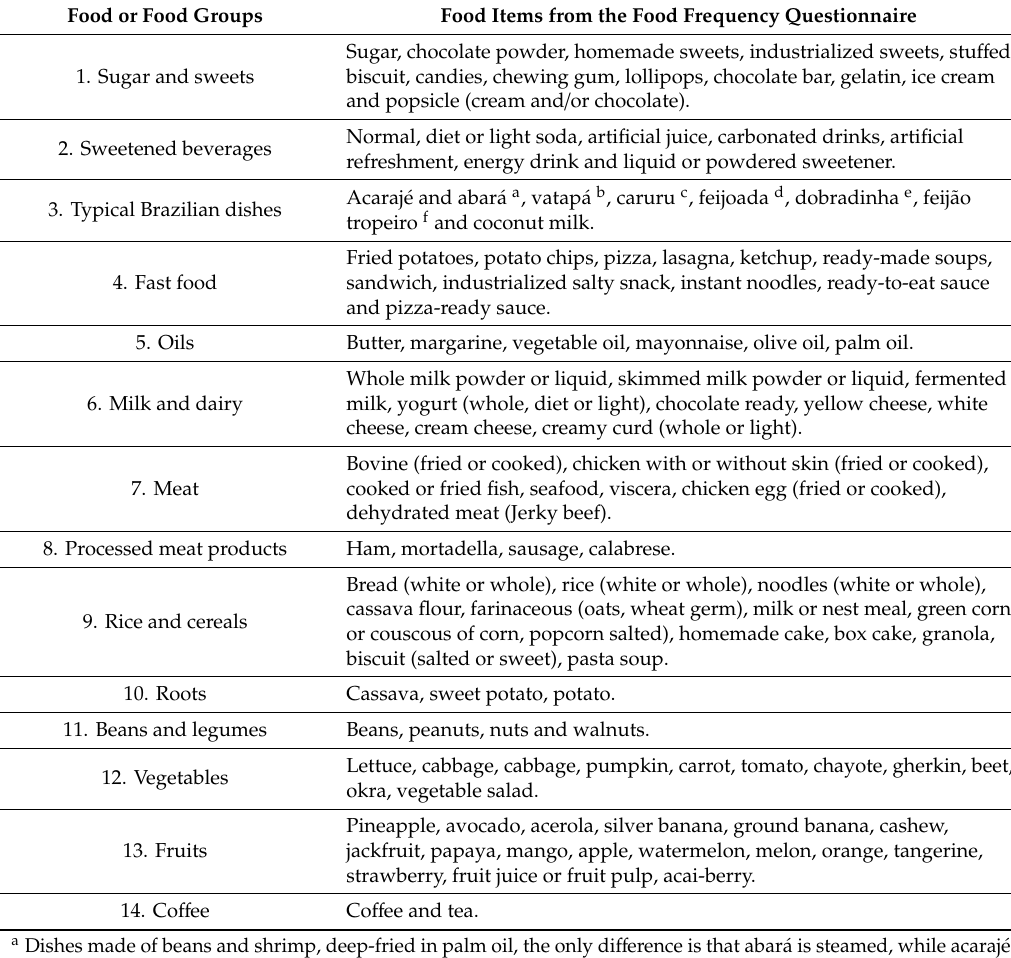
Table 1. Food groups according to similarity in nutritional composition, consumed by adolescents enrolled in the